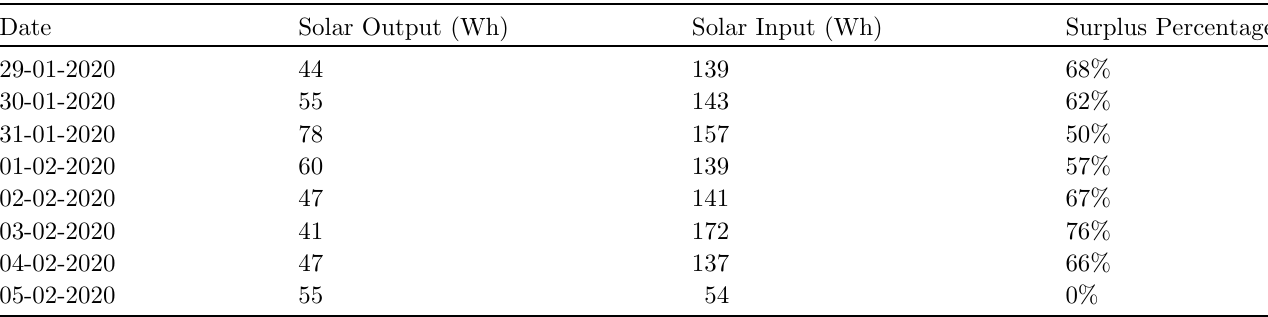
Table 2. Rural SHS solar surplus trend for few days in January and February.